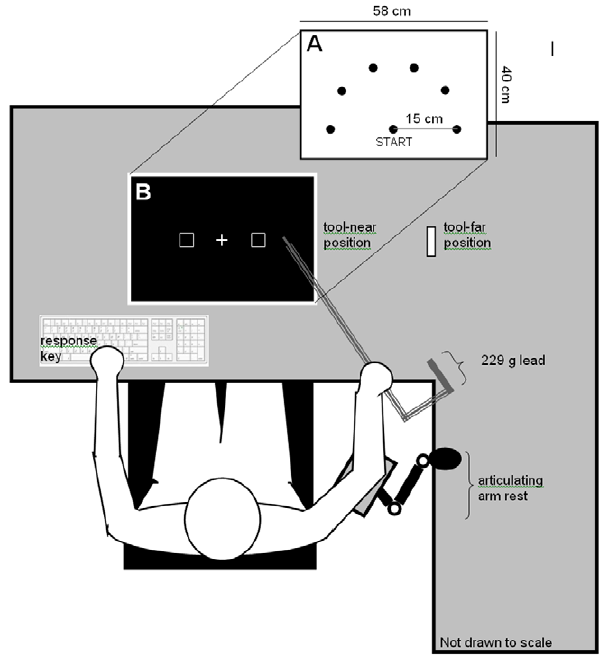
Figure 1. Experimental set up. The layout of the start position and targets for the motor learning task is shown in Panel A. The arrangement of the fixation cross and cue-target placeholders for the visual detection task is shown in Panel B.